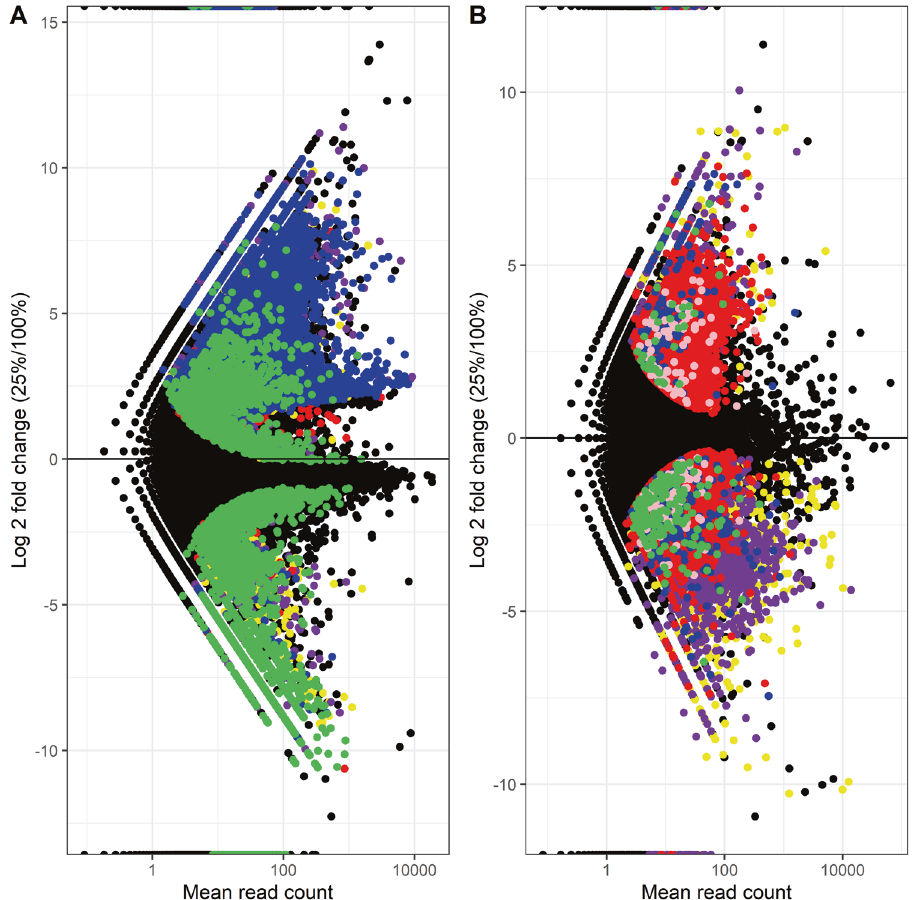
Fig. 2 Volcano plots of transcripts. Volcano plot of transcripts log2 fold change vs. mean relative abundance, with signi fi cantly differently abundant (DA) transcripts highlighted by colors corresponding to their kingdom-level taxonomy for ( A ) roots and ( B ) rhizosphere soil. Blue: fungi, green: plant, red: bacteria, yellow: others, purple: unclassi fi ed, pink: